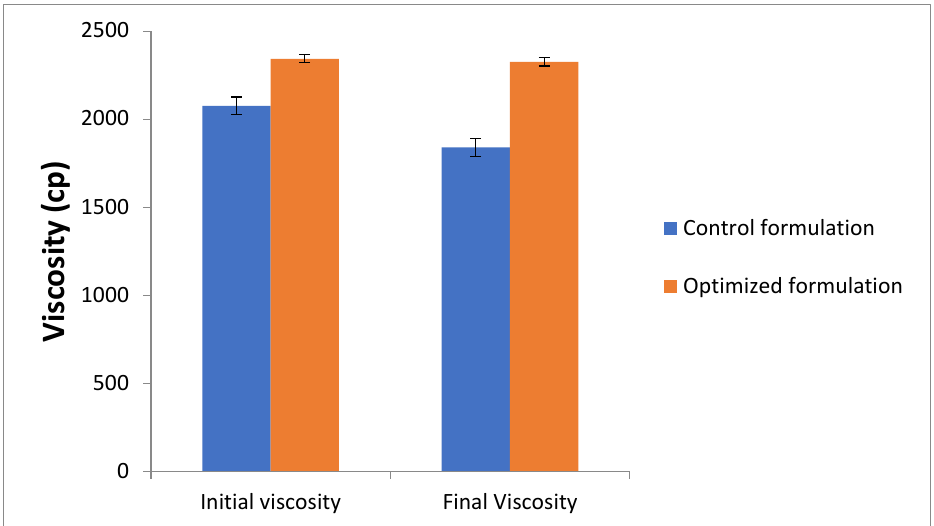
Figure 7. Effect of seven cycles of heating–cooling conditions on viscosity of control and optimized formulations.